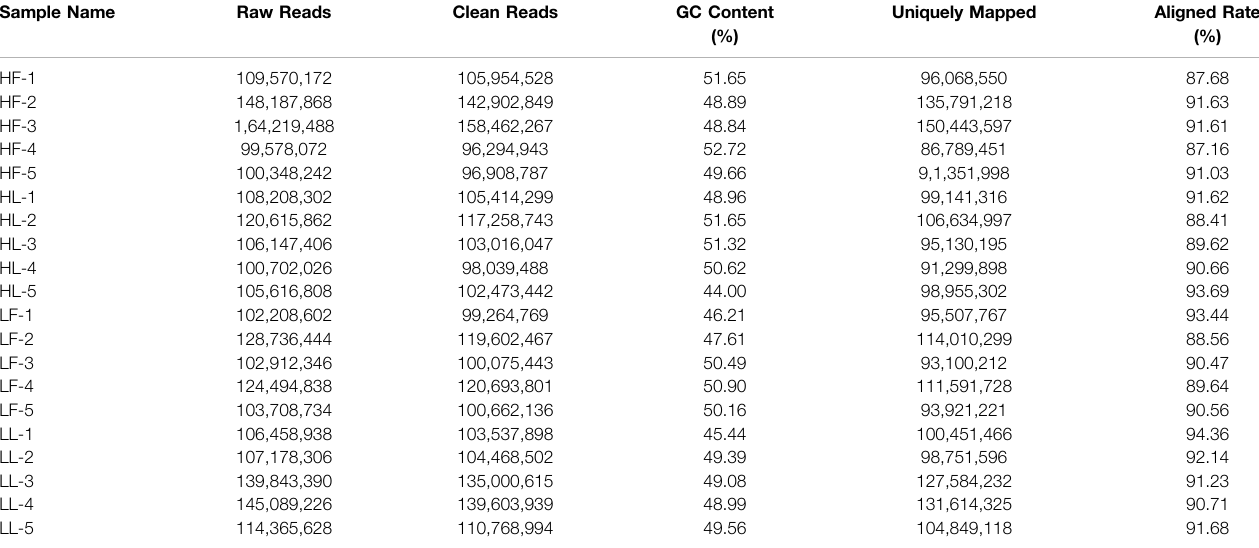
TABLE 2 | Summary of data quality and genome